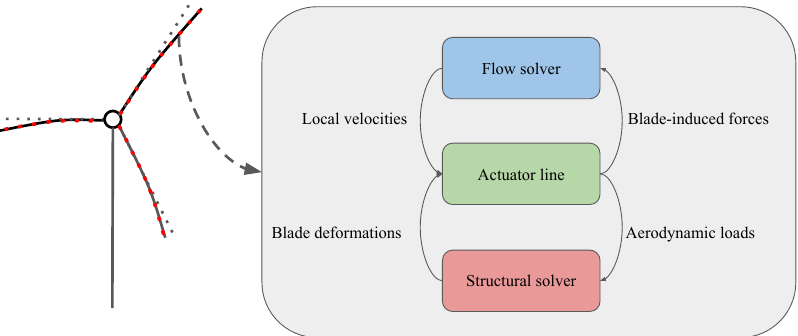
Figure 2. The coupling procedure between the flow solver and the structural solver in the EALM. The arrows in the flowchart represent the variable passing between different modules of the solver.